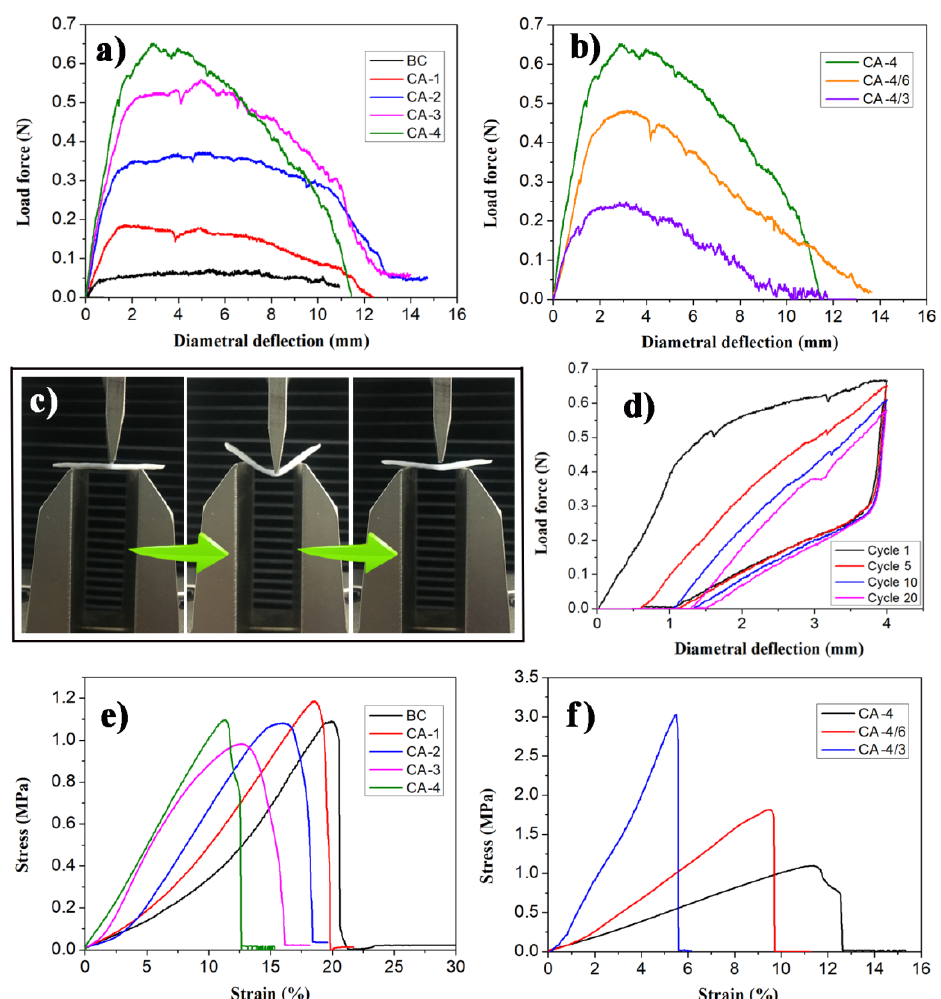
Figure 6. ( a , b ) Stress-strain curves of three-point bending tests on all the samples; ( c ) photographs of a three-point bending test on CA-4; ( d ) stress-strain curves of CA-4 under repeated three-point bending tests; and ( e , f ) stress-strain curves of tensile tests on all the samples.